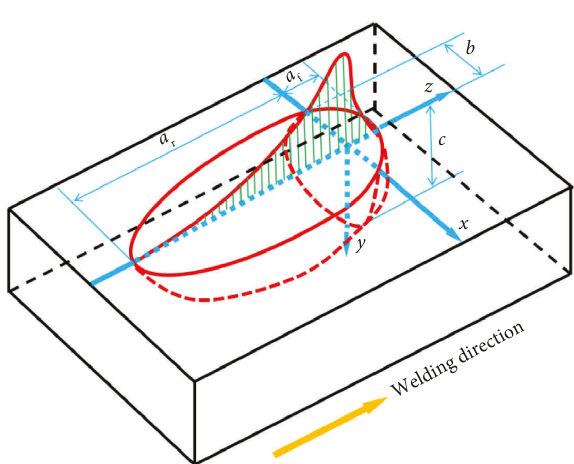
Figure 7: Double-ellipsoidal heat source model.